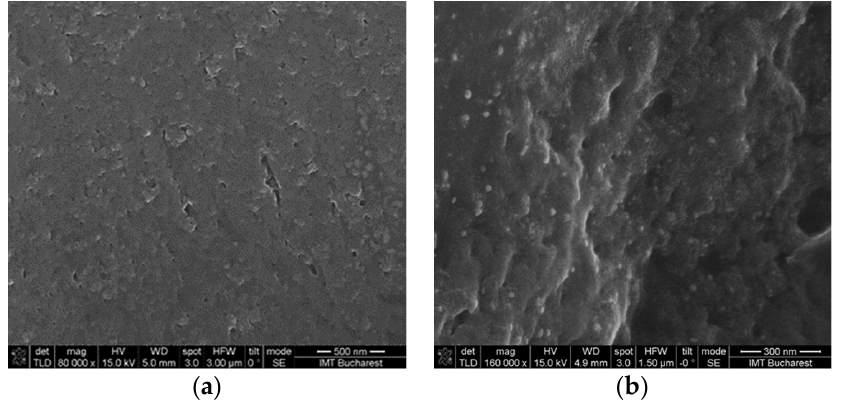
Figure 6. Morphology of the of hydrogels crosslinked with CaCl 2 , after 5 days of drying at room temperature: (a) SEM image of V2 hydrogel and (b) SEM image of V4 hydrogel.